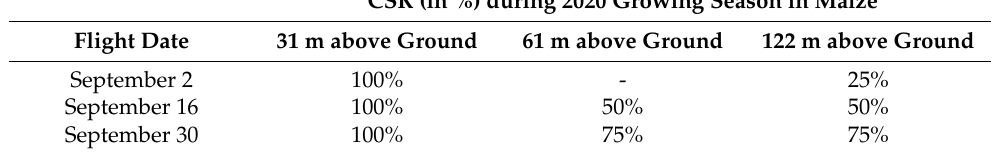
Table 4. The communication success rate (CSR) (in %) for three treatments (31 m, 61 m, and 122 m above the ground) during the 2020 growing season in